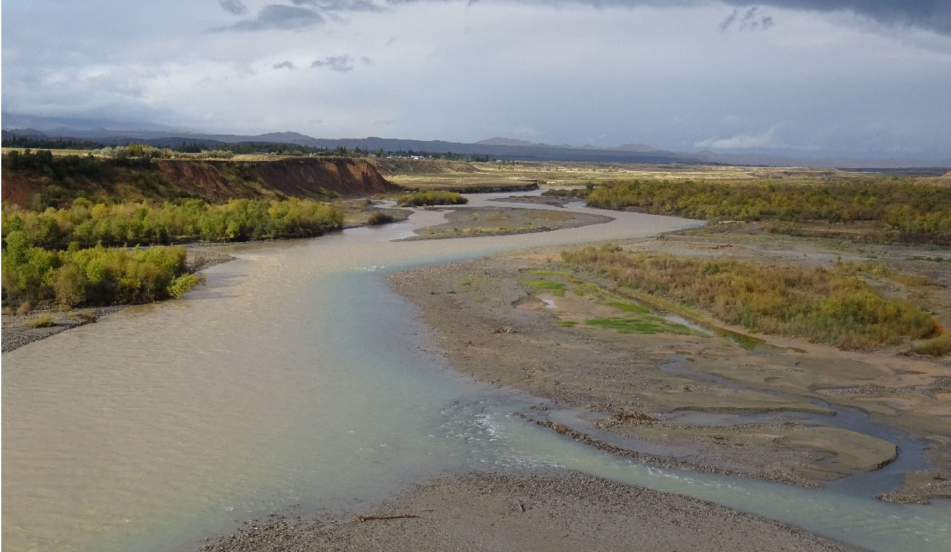
Figure 2. Riparian forests upon the braided Naryn River at Kulanak